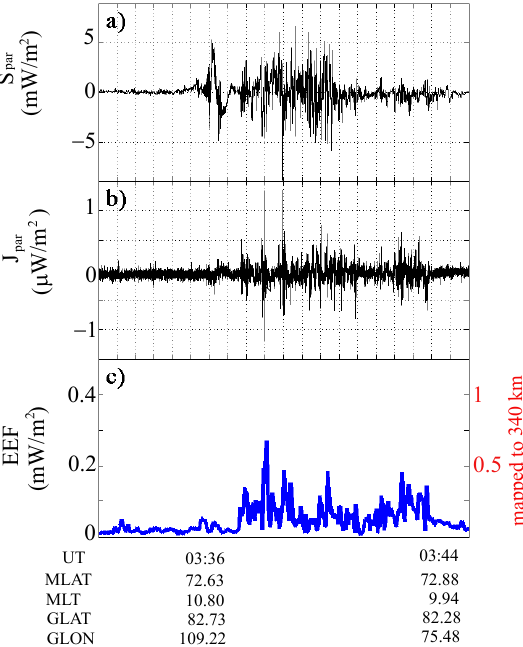
Figure 9. Cluster 3 on 17 July 2008: (a) parallel Poynting flux, (b) parallel current density, (c) electron energy fluxes, where blue colour indicates Earthward direction. Right axis shows EEF mapped to